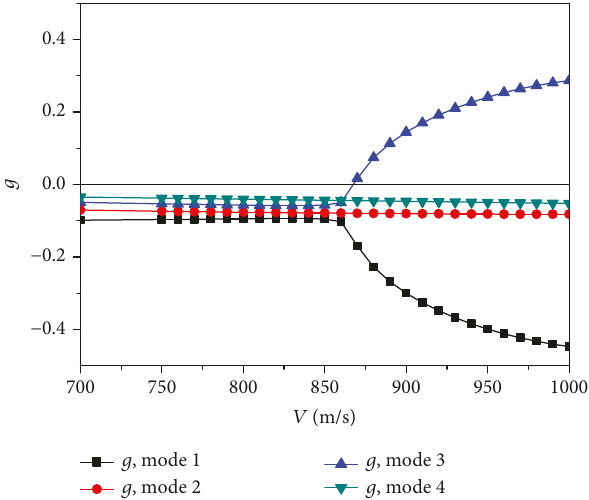
Figure 6: V - g fi gure of the panel (867.5 m/s).